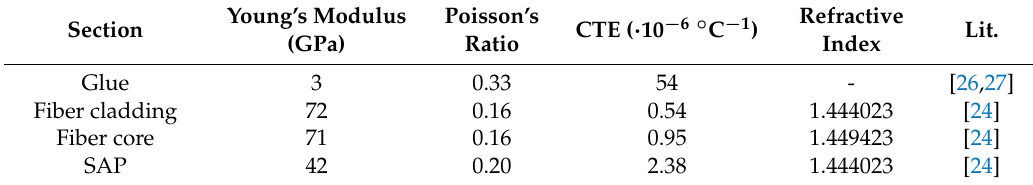
Table 1. The Material Parameters used for mechanical and optical